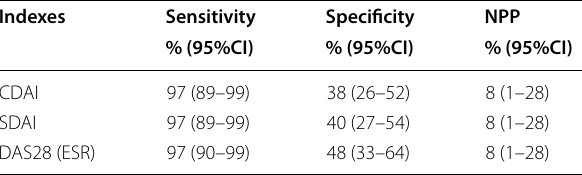
Routine Assessment of Patient Index Data 3; CDAI = Activity Index; SDAI Simple Disease Activity Index; DAS28 (ESR) = Activity Score